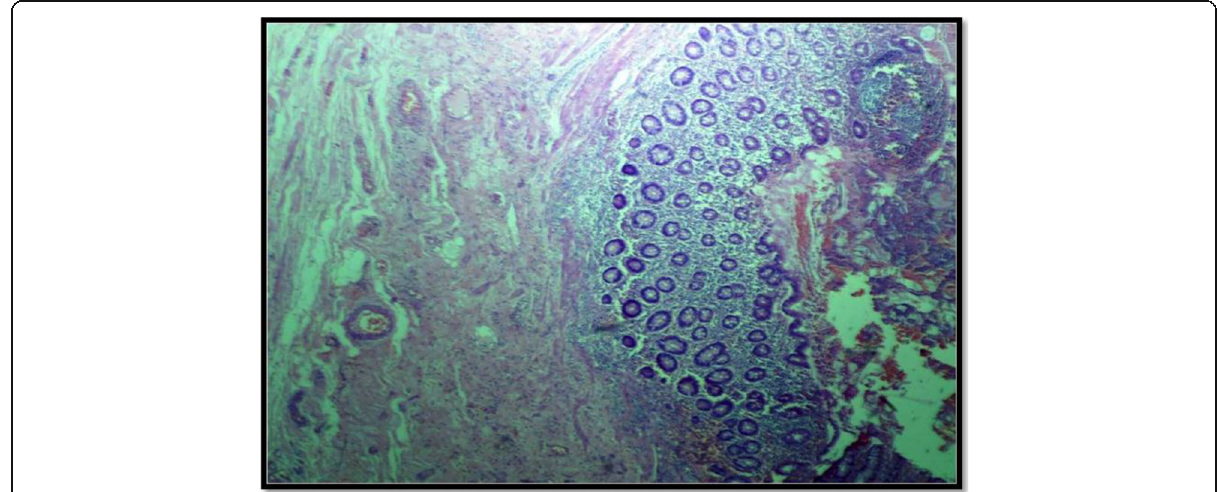
Fig. 5 Histopathology of vitello-intestinal duct showing colonic mucosa and a patent